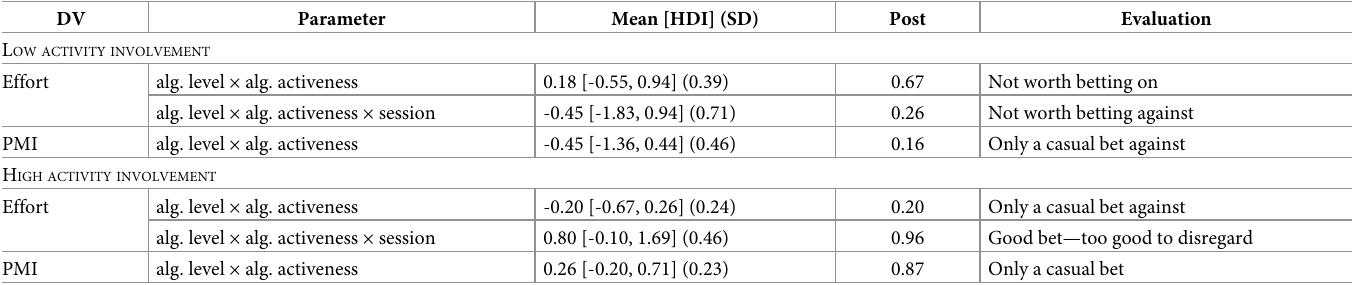
Table 9. Results of Bayesian analyses of effort and perceived motivational impact for people with low and high activity involvement. DV Parameter Mean [HDI] (SD) Post